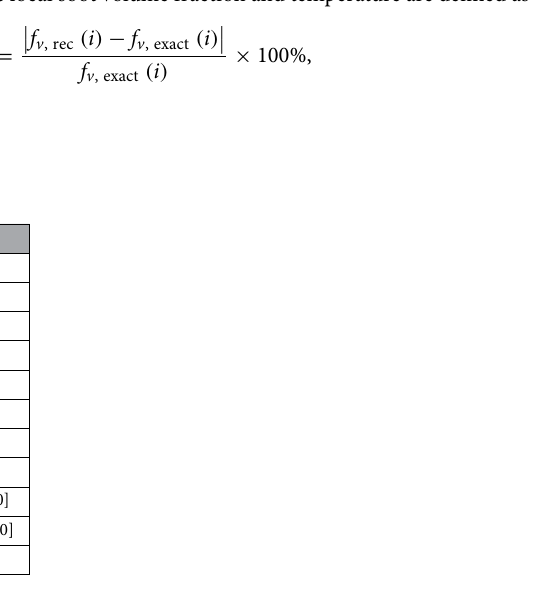
Table 2. Standard parameters of reconstruction